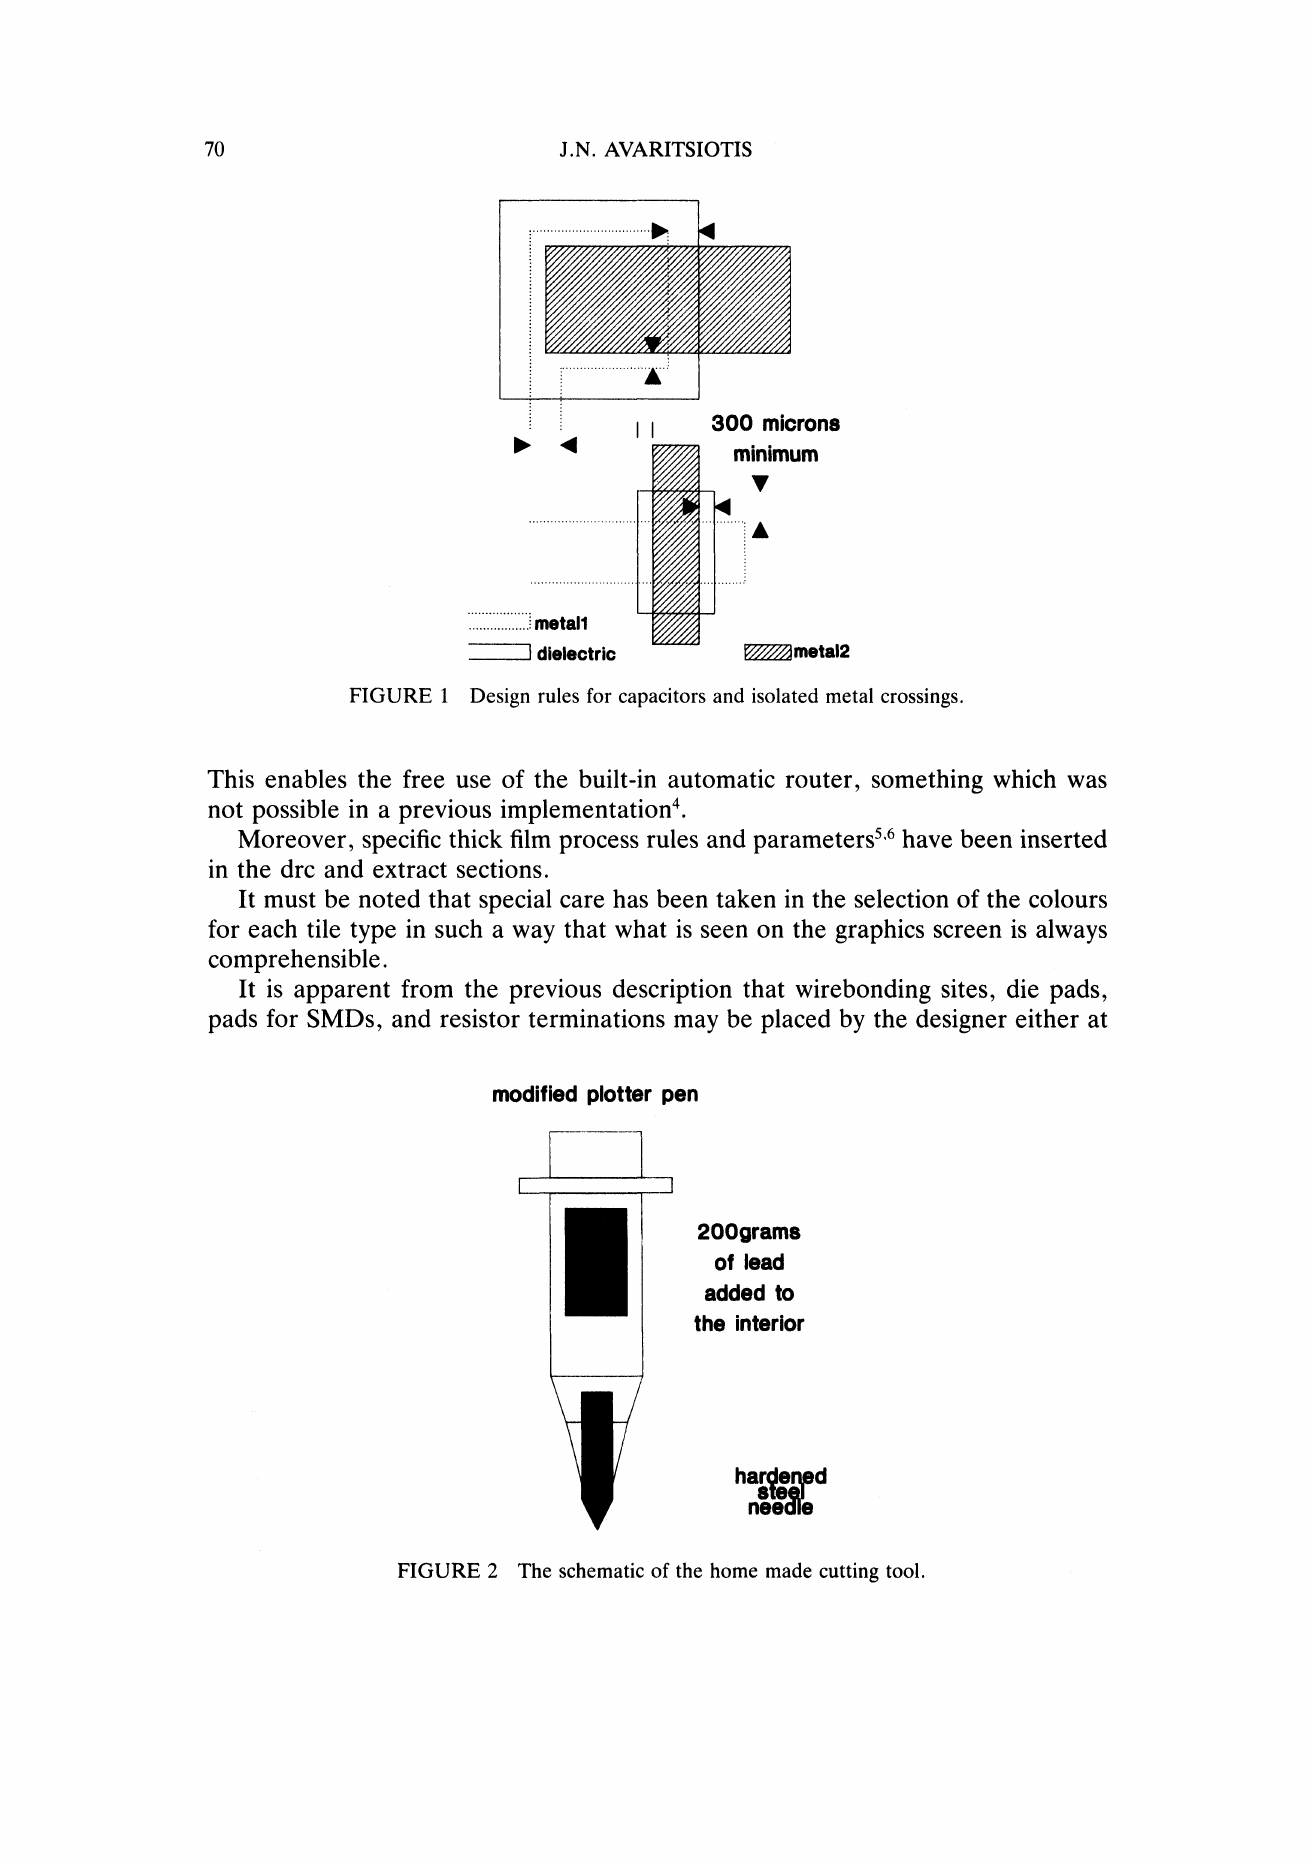
II 300 microns minimum